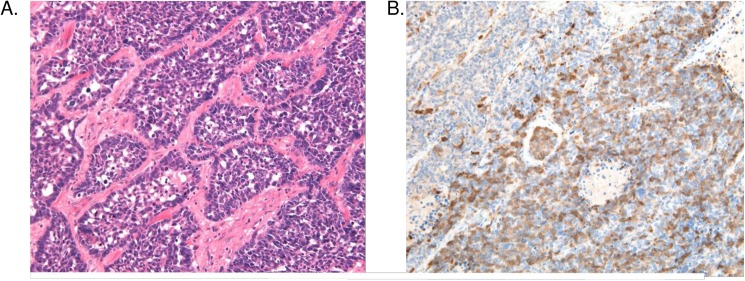
A) Histological appearance of LCNEC (Patient No. 2 of LCNEC in S1 Table, magnified by ×200), and B) Immunohistochemical staining (×200) of AL1A1, using monoclonal rabbit AL1A1 antibody (Abcom Japan, Tokyo, Japan).